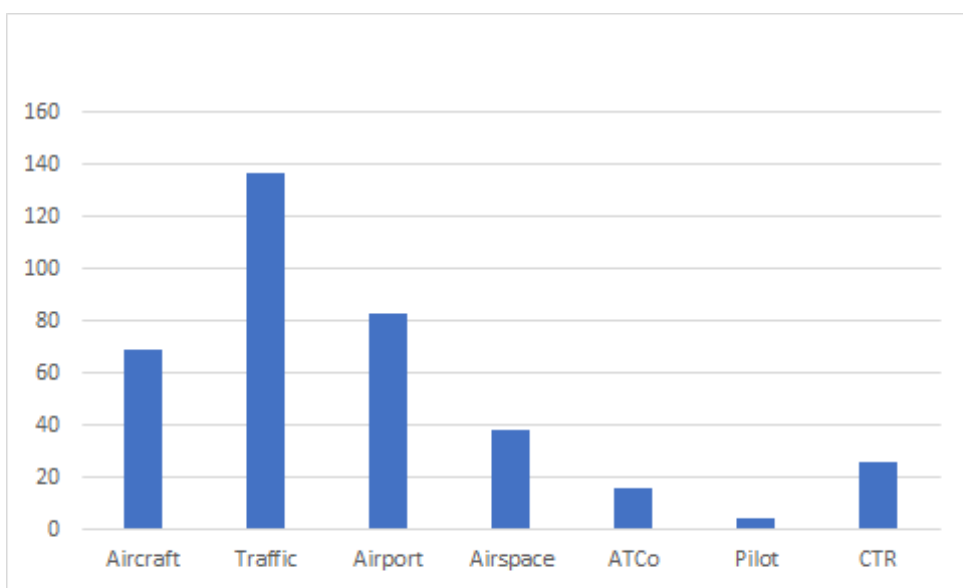
Figure 5. Publication distribution on the different object feature from Table